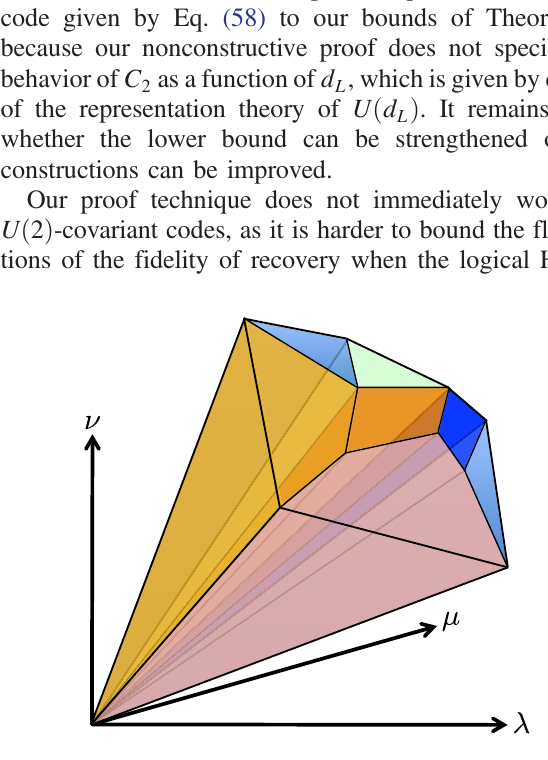
FIG. 5. Smoothness of the Littlewood-Richardson coefficients, required for our proof that random covariant codes can asymp- totically correct against errors. A Littlewood-Richardson coef- ficient c λ μν is the coefficient that counts the degeneracy of the U ð d irrep labeled by the Young diagram λ in the tensor product L Þ of two other irreps labeled by μ and ν . The Littlewood- Richardson coefficients are nonzero in a convex cone in the space of ð μ ; ν ; λ Þ . This cone — or chamber complex — is